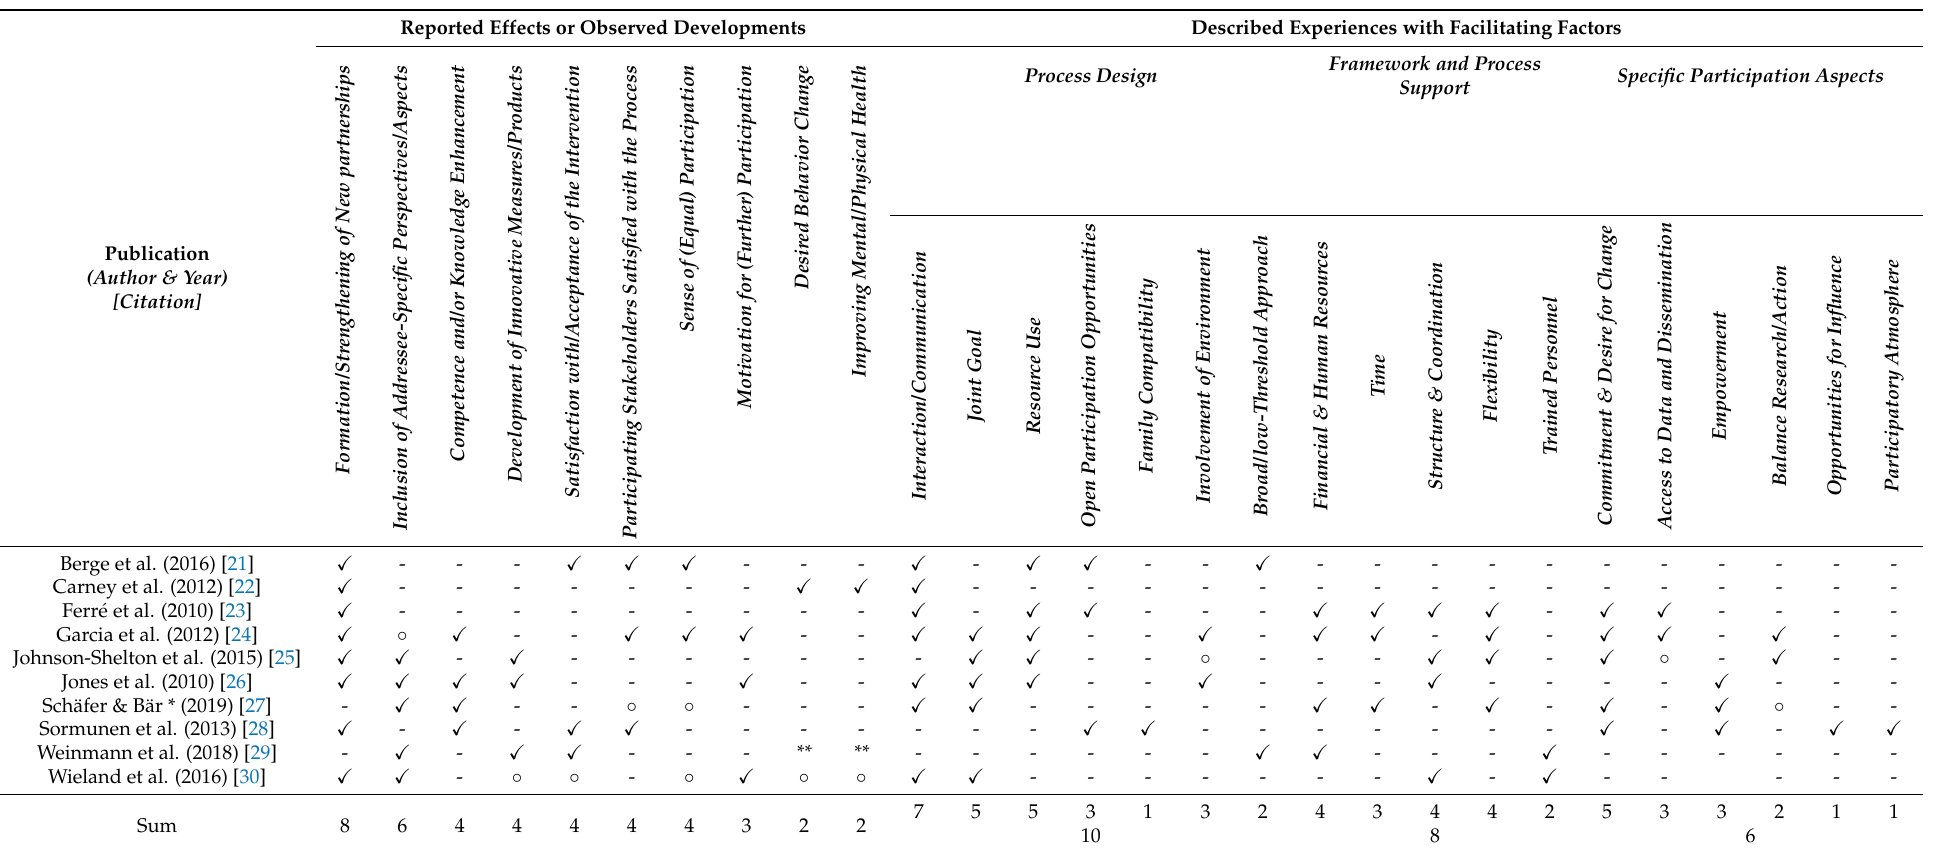
Table 3. Described experiences [reported effects & described facilitating factors] with the participatory approaches and measures of family health promotion in the publications